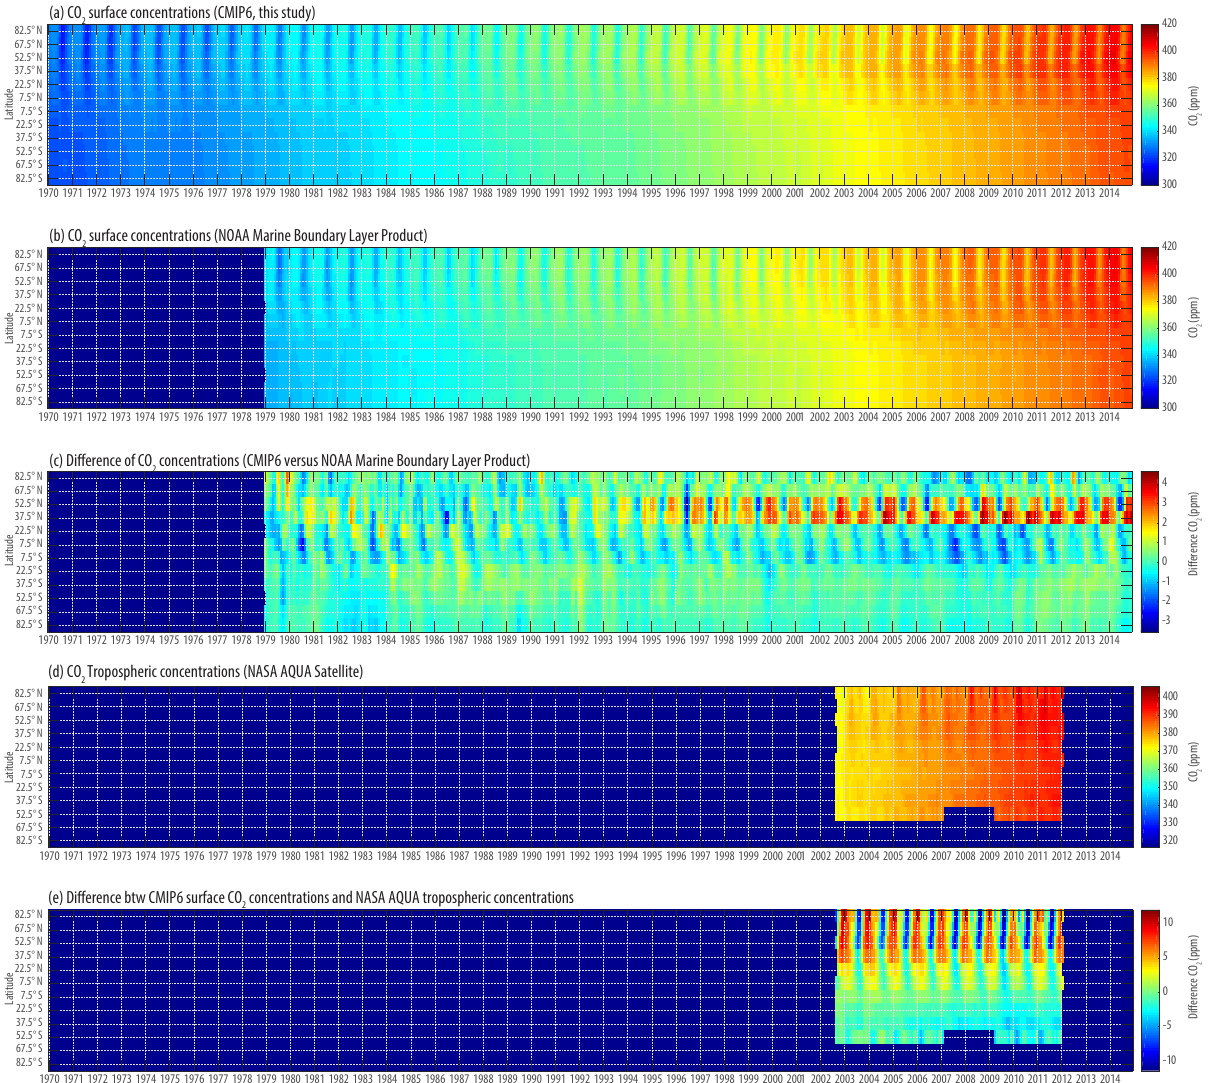
Figure 17. Comparison of the CMIP6 historical CO 2 emissions (a) with the NOAA Marine Boundary Layer (MBL) product from 1979 to 2014 (b) . Differences indicate that a seasonal higher CO 2 concentration is implied by the CMIP6 data of up to 5ppm in mid-latitude northern bands, whereas some monthly tropical CO 2 mole fractions tend to be slightly lower in the CMIP6 product compared to NOAA MBL (c) .